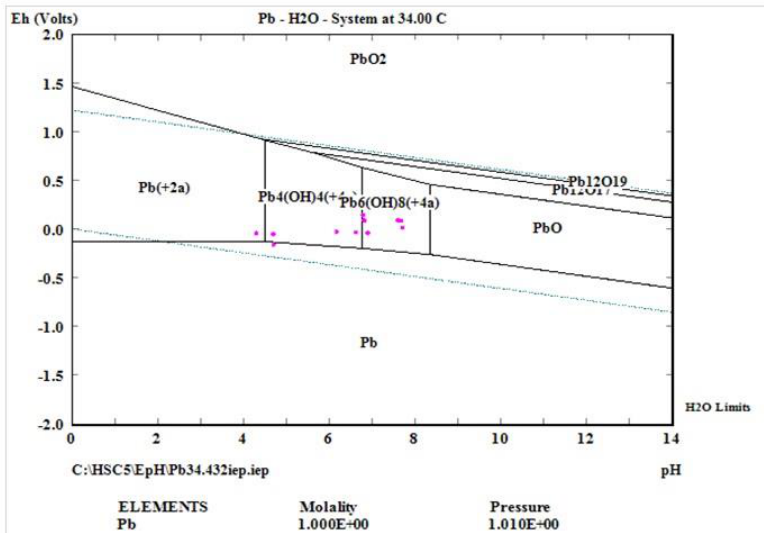
Fig. 5(c): Speciation of Pb in different Eh values in Tehran rainwater samples after the PEC process